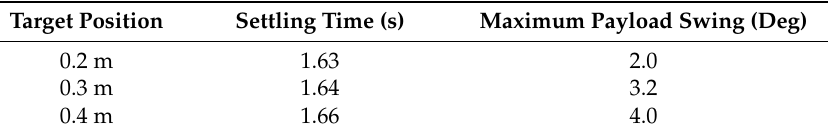
Table 6. Performance within a time optimal solution.